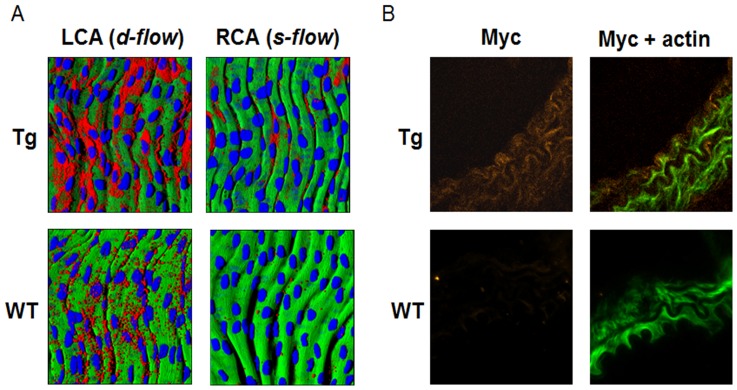
Potentiation of disturbed flow-stimulated VCAM1 by nuclear Trx1.A) Frozen sections of LCA and RCA from NLS-Trx1 Tg and WT littermate mice were examined for VCAM1 expression by en face fluorescence confocal examination (red, VCAM1; blue, nucleus; green, elastic layer). B) LCA of WT and Tg were examined for NLS-Trx1 (Myc epitope tag) expression using immunofluorescence staining on frozen section by probing with an antibody against Myc (orange, Myc; green, actin phalloidin).